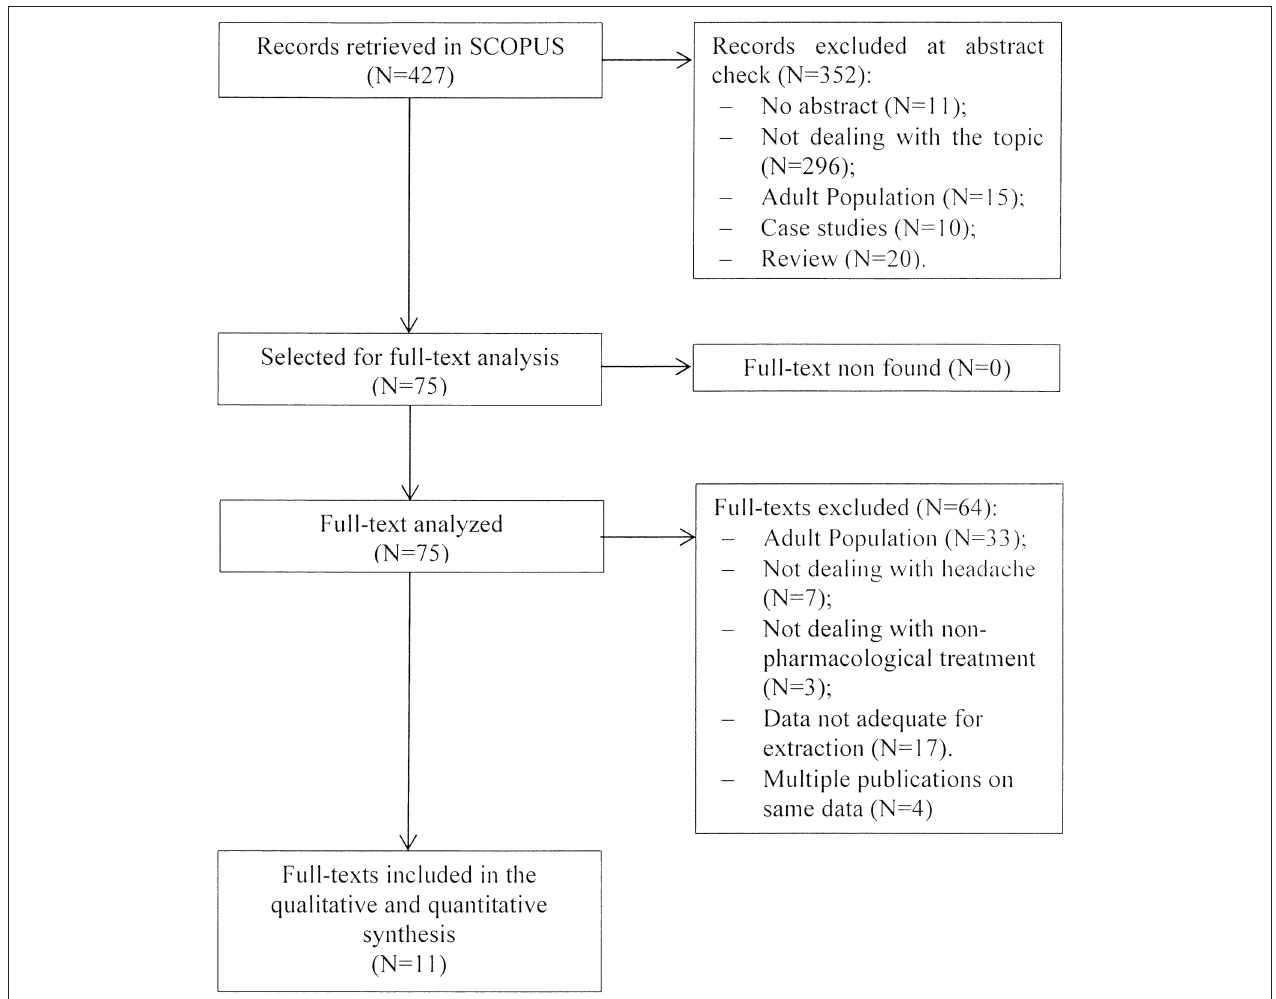
FIGURE 1 | Flowchart of papers’